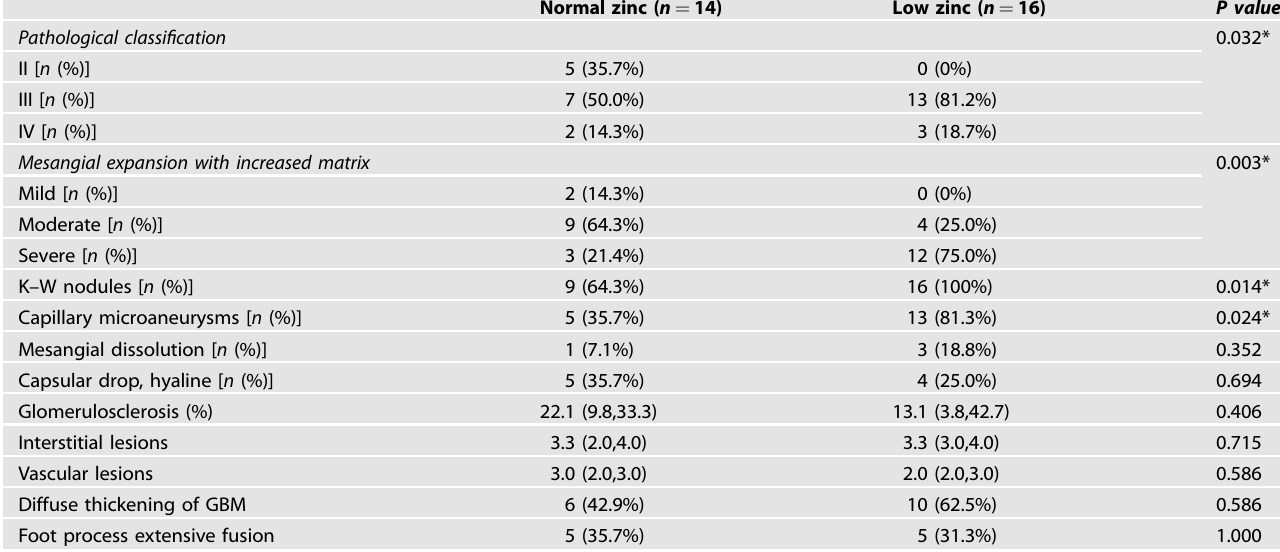
Table 2. Relationship of zinc with pathological